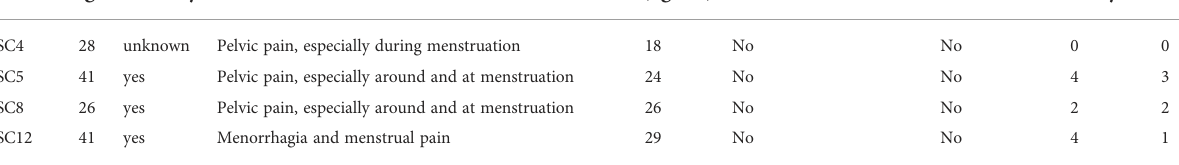
TABLE 2 Characteristics of tissue